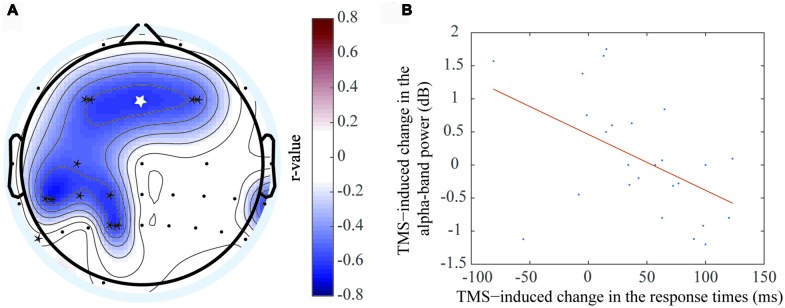
Negative correlation was exhibited between the ERSP value difference of the theta oscillation and RT difference. (A) The electrodes with significant negative correlations included F3 (r = −0.559, P < 0.01**), Fz (r = −0.726, P < 0.05*), F4 (r = −0.535, P < 0.01**), C3 (r = −0.527, P < 0.05*), CP1 (r = −0.607, P < 0.05*), CP3 (r = −0.52, P < 0.05*), CP5 (r = −0.661, P < 0.01**), P7 (r = −0.601, P < 0.05*), P1 (r = −0.638, P < 0.01**). (B) The correlation at the Fz electrode, which was shown in figure (A) with the white asterisk.